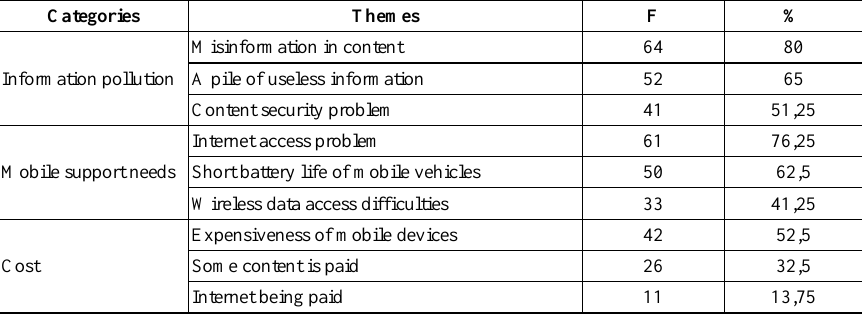
Table 5. Students' views on the disadvantages of mobile learning